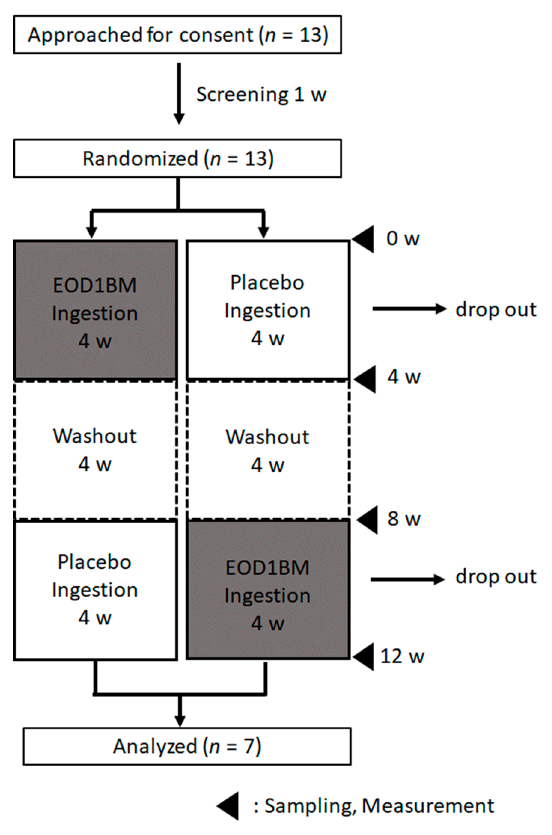
Figure 1. Test design. w: weeks. EOD1BM: Euglena gracilis EOD-1 biomass.